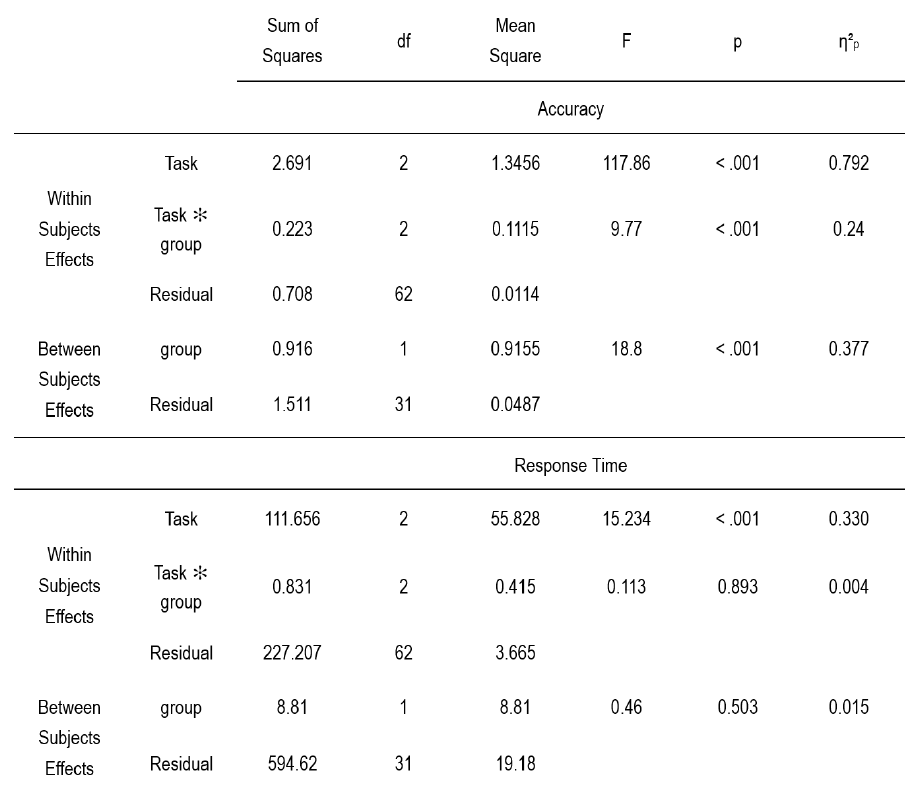
Within and between subjects’ effects in task and group